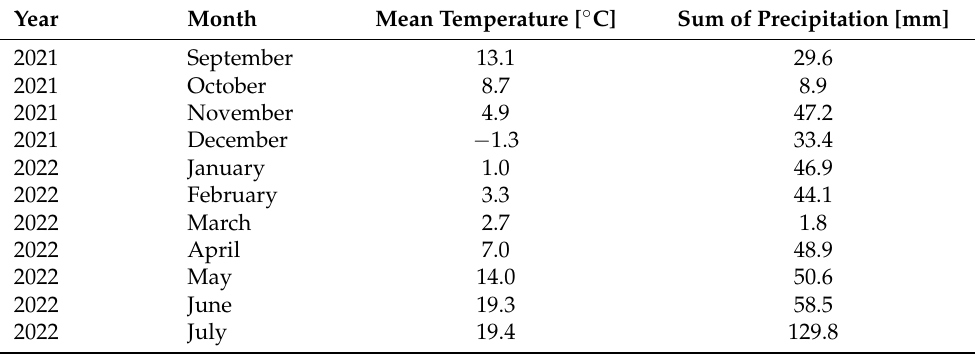
Table 2. Weather conditions from period of winter rye sowing to the end of vegetation.